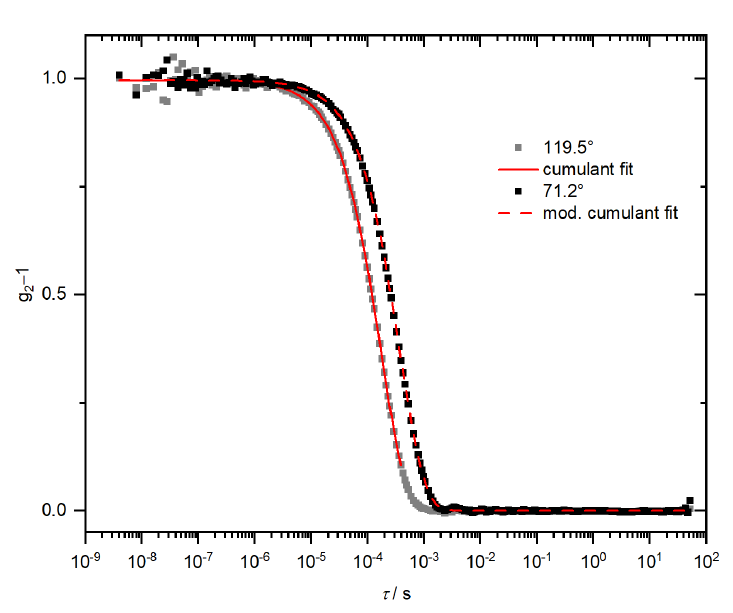
Figure 4. Two correlation functions measured simultaneously at both detection angles. The sample used here was a diluted 50nm (diameter) polystyrene-sphere standard in H 2 O at a temperature of 10.5°C.